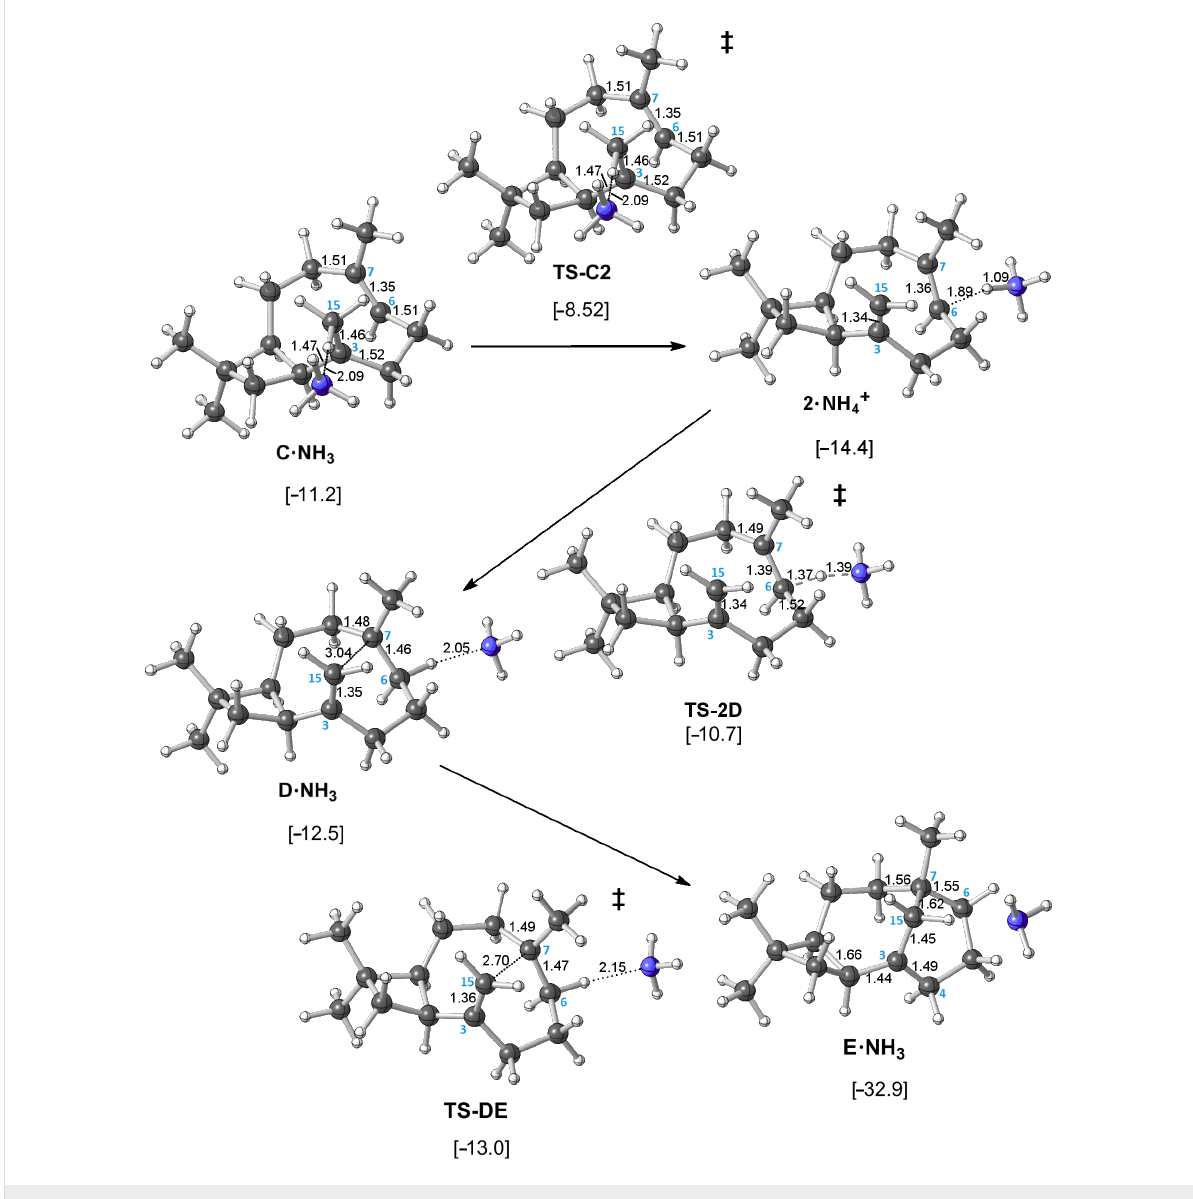
Figure 7: Computed pathway for the conversion of C to E in the presence of ammonia. Relative energies shown (kcal/mol) were calculated at the mPW1PW91/6-31+G(d,p)//B3LYP/6-31+G(d,p) level. Here energies are relative to that for a complex of A and NH 3 .